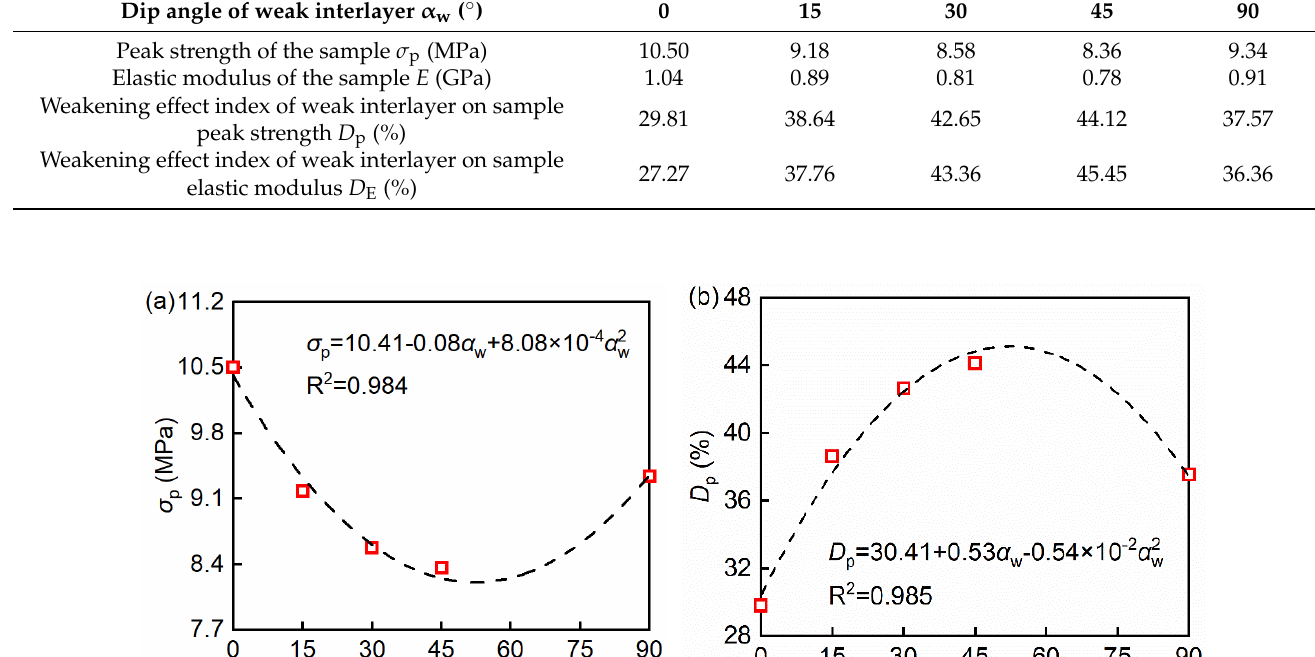
Table 6. The σ p , E , D p , and D E for weak interlayer with different dip angles. Dip angle of weak interlayer α w (°)